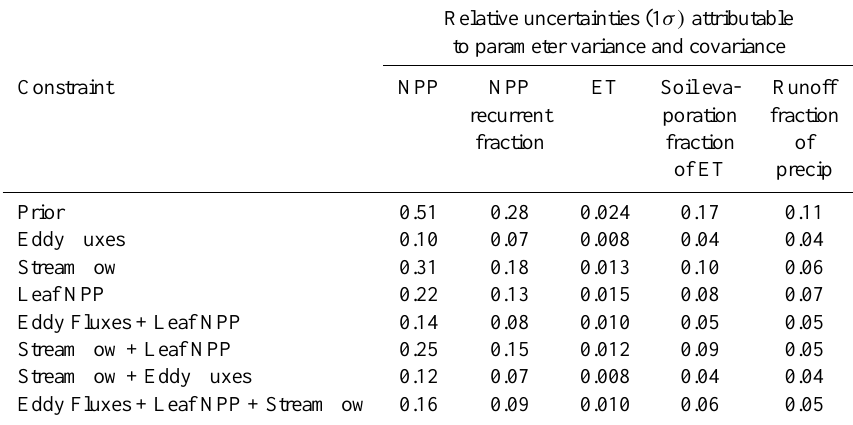
Table A1. Uncertainties in mean (1990–2011) Australian continental carbon and water fluxes, associated with prior parameters and 7 param- eter sets obtained by using different observation sets and combinations thereof in the parameter estimation procedure. Uncertainties represent the relative 1- σ uncertainty attributable to parameter variance and covariance, calculated using Eq. (3).